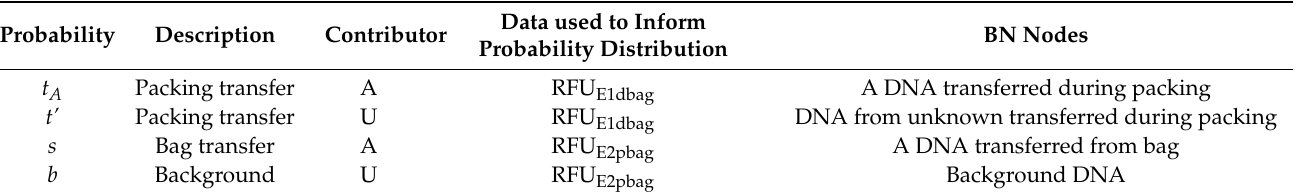
Figure 7. Bayesian network for the “drugs stored in gym bag” example showing data sets and models used to instantiate the nodes. Table 2. Relationship of probabilities of DNA transfer from individuals A (POI) and U (unknown), showing the datasets that were used to calculate probability distributions, along with the BN nodes instantiated. See nomenclature Section 2.5.1 for definitions of